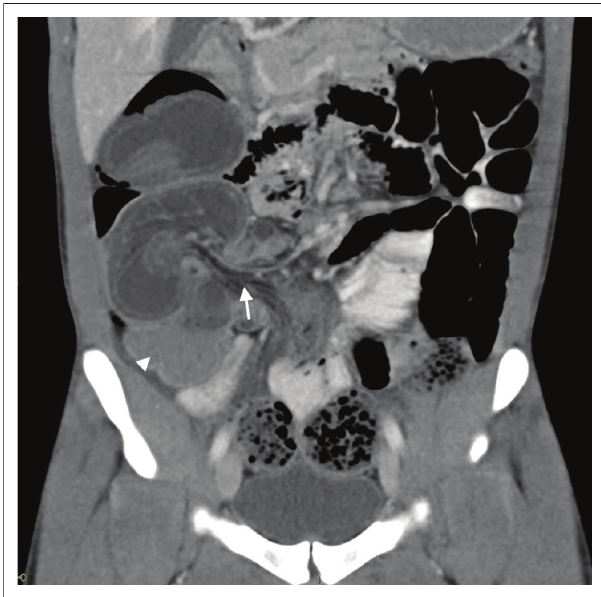
Source : CT Department, Grey’s Hospital Radiology, Pietermaritzburg (obtained from actual patient) FIGURE 2: Contrast-enhanced coronal computed tomography of the abdomen demonstrating invagination of the terminal ileum along with its mesentery (arrow) into the ascending colon (arrowhead). Histopathological examination of the resection specimen found the lead point to be a submucosal tumour with features of a low-grade B-cell MALT